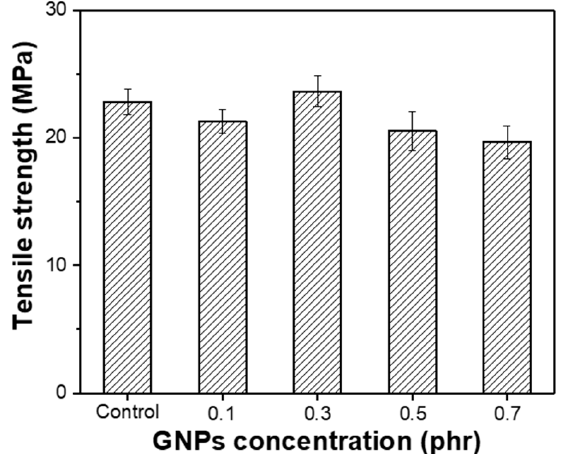
Figure 7. Tear strength of the control sample and the DOP-modified GNPs/NR rubber composites with various graphene contents.